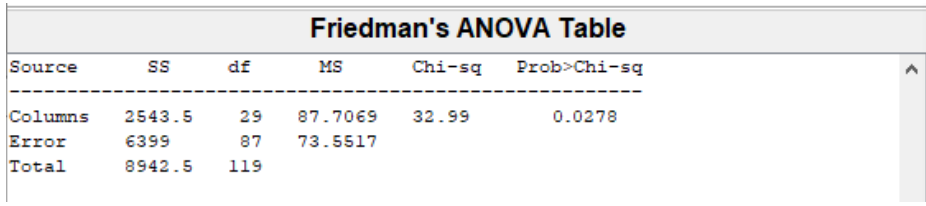
( E ) Figure 3. Box plot for the results of the second identification step. ( A ) objective function J 2 ; ( B ) pa- rameter 𝑌 (cid:2871) ; ( C ) parameter 𝑌 (cid:3004)(cid:3009) (cid:3120) ; ( D ) parameter 𝜇 (cid:2870)(cid:3040)(cid:3028)(cid:3051) ; ( E ) parameter 𝐾 (cid:3020) (cid:3118) . As shown in Figure 3A, the median of the objective function values obtained from 30 runs of GA is better than that of the rest of the results, including the minimum achieved by the other algorithms. On the other hand, the SD in the case of GA is larger. The best SD is observed for the results of COA, followed by those of FA. The median of 30 runs of CS is better than the median of COA and FA. These observations are a reason to conclude that the advantages and disadvantages of the considered algorithms should be analyzed in depth. Subsequently, a hybrid metaheuristic can be designed to combine the ad- vantages. It is shown that the distribution of FA estimates of the model parameters is smaller